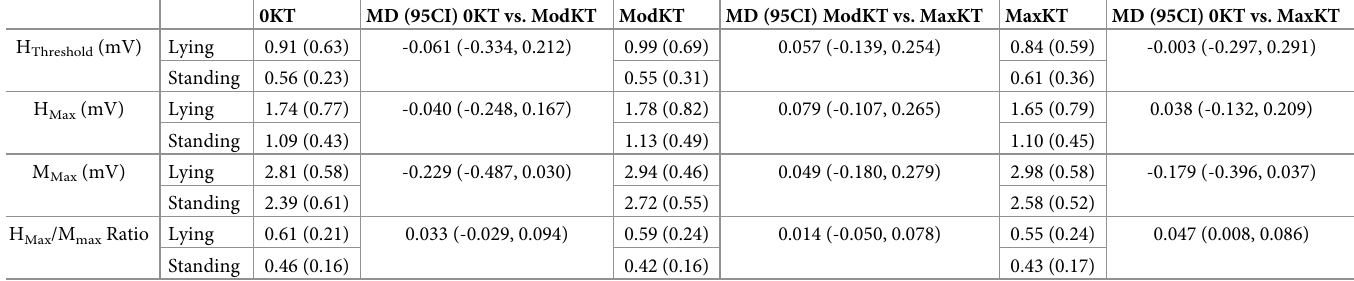
Table 1. Mean (SD) of all H-reflex and M-wave variables (merged across time) on each tension (0KT, ModKT, and MaxKT) for lying and standing postures. Mean difference (MD) along with the 95% confidence interval (95CI) of the pairwise comparisons for tensions (posture and time merged) were also presented